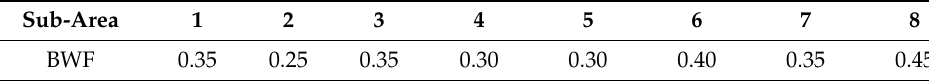
Table 4. Balancing weight factor (BWF) for each